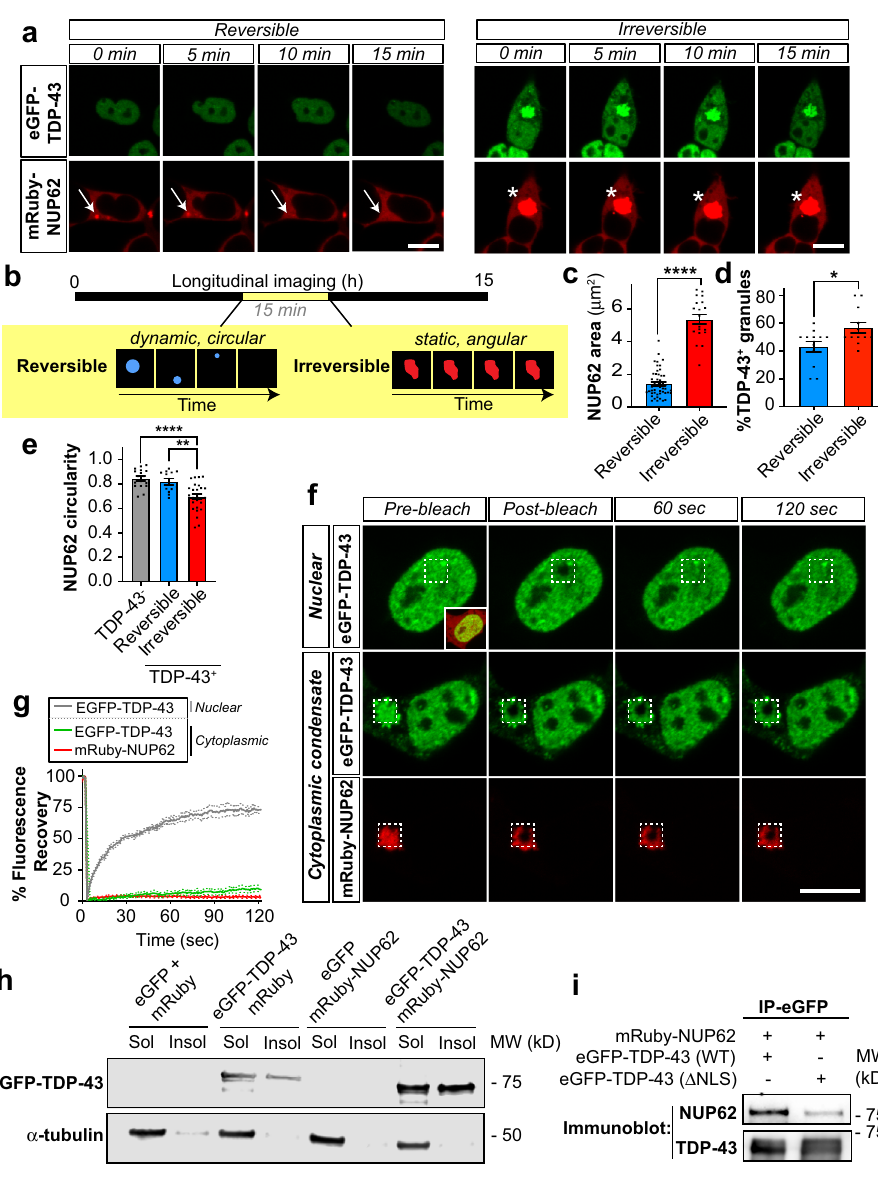
the TDP-43 NLS, promote the soluble to insoluble transition of and Western blot analyses of HEK293 cells co-expressing eGFP- TDP-43 and mRuby-NUP62 and found that this co-expression these proteins in cellular models. elevated insoluble eGFP-TDP-43 levels (Fig. 5h, Supplementary Figure 5d) indicating that cytoplasmic NUP62:TDP-43 inter- Nup62 is a modi fi er of expanded G4C2 expression toxicity in actions promote the formation of pathological insoluble Drosophila . Our observations indicate that NUP62 mislocaliza- TDP-43, likely through deleterious phase transitions 109 . We tion is a feature of C9-ALS/FTLD models but the implications of validated the mRuby-NUP62:eGFP-TDP-43 interaction by co- NUP62 dysregulation on neuron survival is not known. To immunoprecipitation. HEK293 cells were co-transfected with address this, we performed a genetic screen in the (G4C2) 30 - mRuby-NUP62 and eGFP-TDP-43 (WT and Δ NLS). Isolated expressing Drosophila to determine whether FG nup depletion eGFP-TDP-43 protein complexes through immunoprecipita- modulates neurotoxicity associated with the rough eye phenotype tion and immunoblotting for NUP62 and TDP-43 showed both (Fig. 6a, b, Supplementary Figure 6a-c). The GMR-GAL4 system NUP62 and TDP-43 in the co-immunoprecipitation samples was used to drive (G4C2) 30 and FG nup shRNA expression in the fl y eye. Reduction of mammalian conserved FG nups through but with reduced NUP62 levels in eGFP-TDP-43 ( Δ NLS) co- immunoprecipitation group (Fig. 5i). Furthermore, we found RNAi was validated through RT-qPCR (Supplementary Fig- that HEK293 cells co-expressing mRuby-NUP62 and eGFP- ure 6d-g) and progeny rough eye phenotype was scored in a TDP-43 ( Δ NLS) reporters did not colocalize (Supplementary blinded manner 110 . Expression of the (G4C2) 30 repeat expansion Figure 5e) suggesting the TDP-43 NLS may be required for this induces the rough eye phenotype when compared to control pathologic interaction with NUP62. Together, these data show (UAS-eGFP) Drosophila (Fig. 6a, Supplementary Figure 6b) 34 . that cytoplasmic NUP62 and TDP-43 interactions, driven by Downregulation of speci fi c FG nups that increased the rough eye NATURE COMMUNICATIONS| (2022) 13:3380